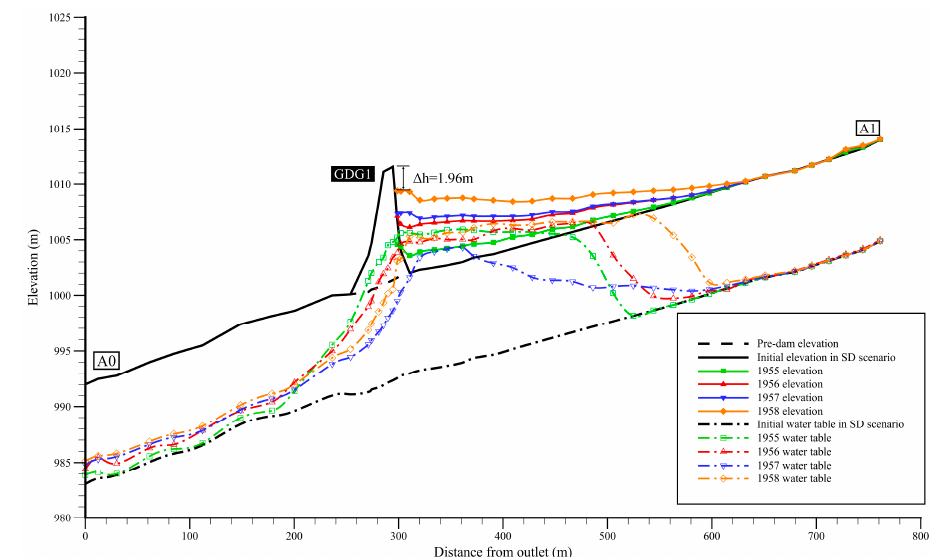
Figure 8. Surface elevation changes and water table changes of GDG1 dam-controlled reach during SD scenario. Note that the simulation results in the end of month 11 of each year were used for comparison.